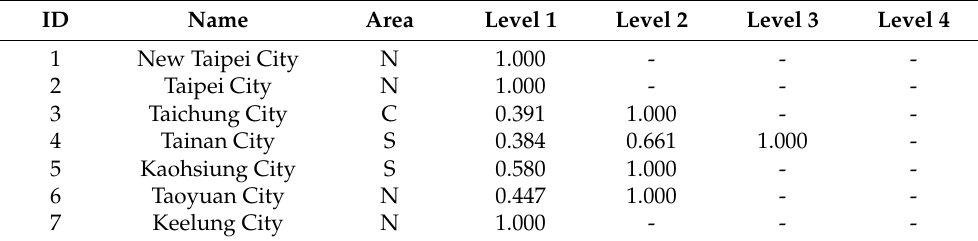
Table 6. Multi-level efficiency frontiers of gasoline of counties and cities in